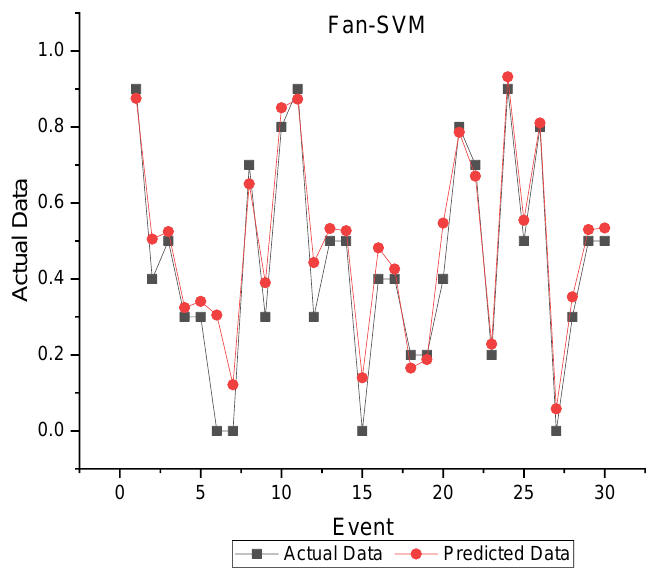
Figure 14. Representation of actual and prediction data for fan SVM.